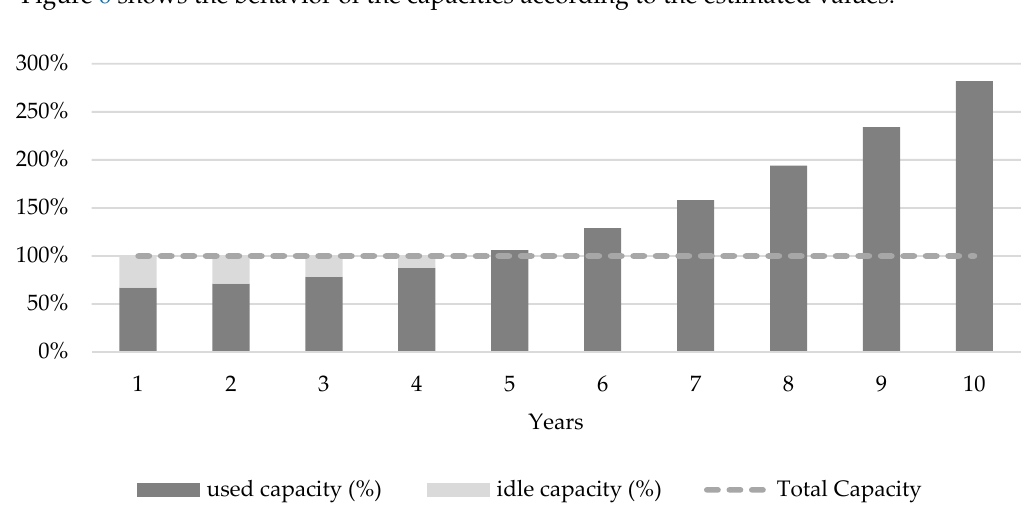
Figure 6. Comparison between used and idle capacity along the planning horizon.